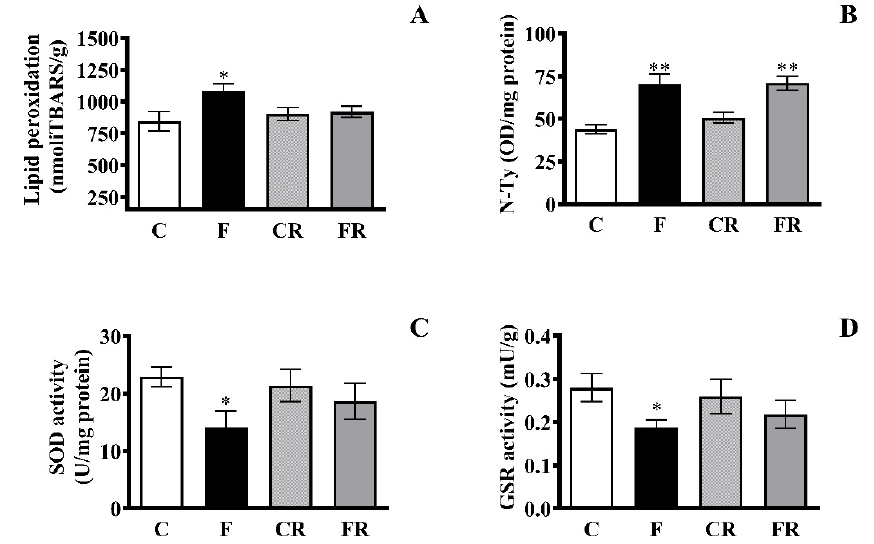
Figure 6. Markers of oxidative status. ( A ) TBARS ( B ) N-Tyr levels, ( C ) SOD activity, ( D ), GSR activity in the hippocampi of control (C), fructose-fed (F), control rescued (CR), and fructose-rescued (FR) rats. Data are the means ± SEM of eight rats/group. * p < 0.05 versus control rats; ** p < 0.01 versus control rats. Source of variation: one-way ANOVA followed by Tukey’s post-test.